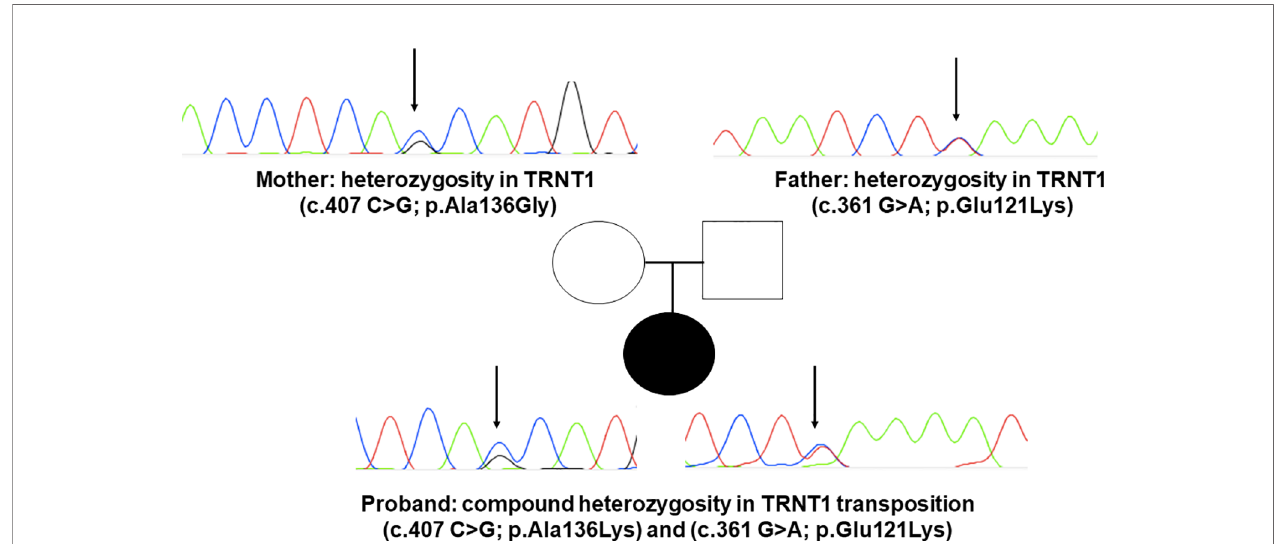
FIGURE 3 | DNA sequence electropherograms demonstrating mutations p.Ala136Lys and p.Gly121Lys in TRNT1 . Sanger sequencing results for TRNT1 mutations in SFID in compound heterozygous status in the proband. The father carries p.Gly121Lys and the mother p.Ala136Lys, both in heterozygous fashion. Electropherograms detail each of the two newly reported mutations, indicated by black